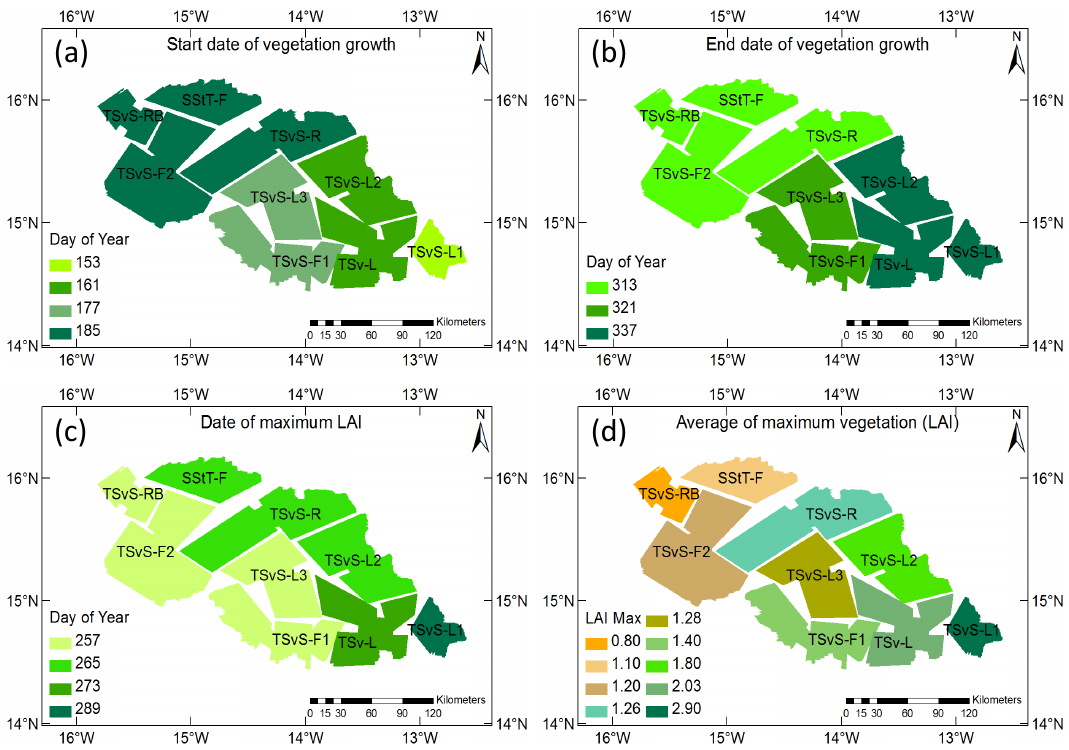
Figure 8. Spatial variations of some characteristic parameters in the vegetation phenological cycle over the period 2000 to 2010: ( a ) start of the growing season; ( b ) end of the growing season; ( c ) date of maximum LAI; and ( d ) the maximum value of